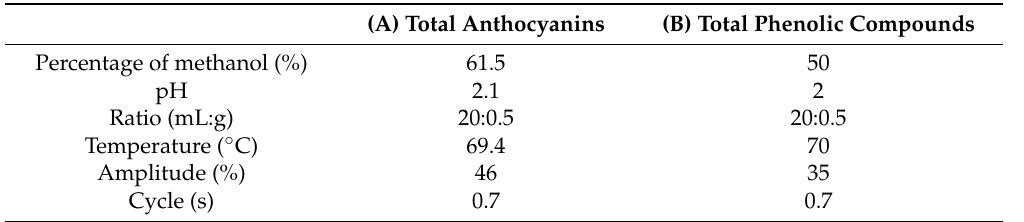
Table 3. Optimal conditions for ultrasound-assisted extraction. (A) Total anthocyanins; and, (B) Total phenolic